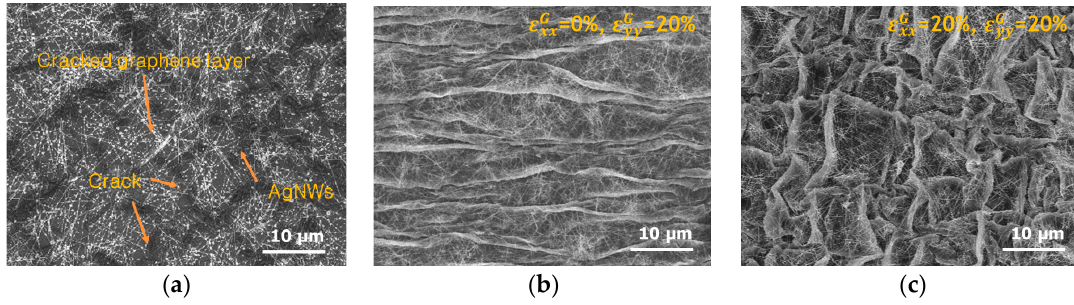
Figure 2. SEM images of the graphene–AgNWs hybrid electrode: ( a ) flat surface morphology, ( b ) uniaxially compressive strain of 20% and ( c ) biaxially compressive strain of 20%.